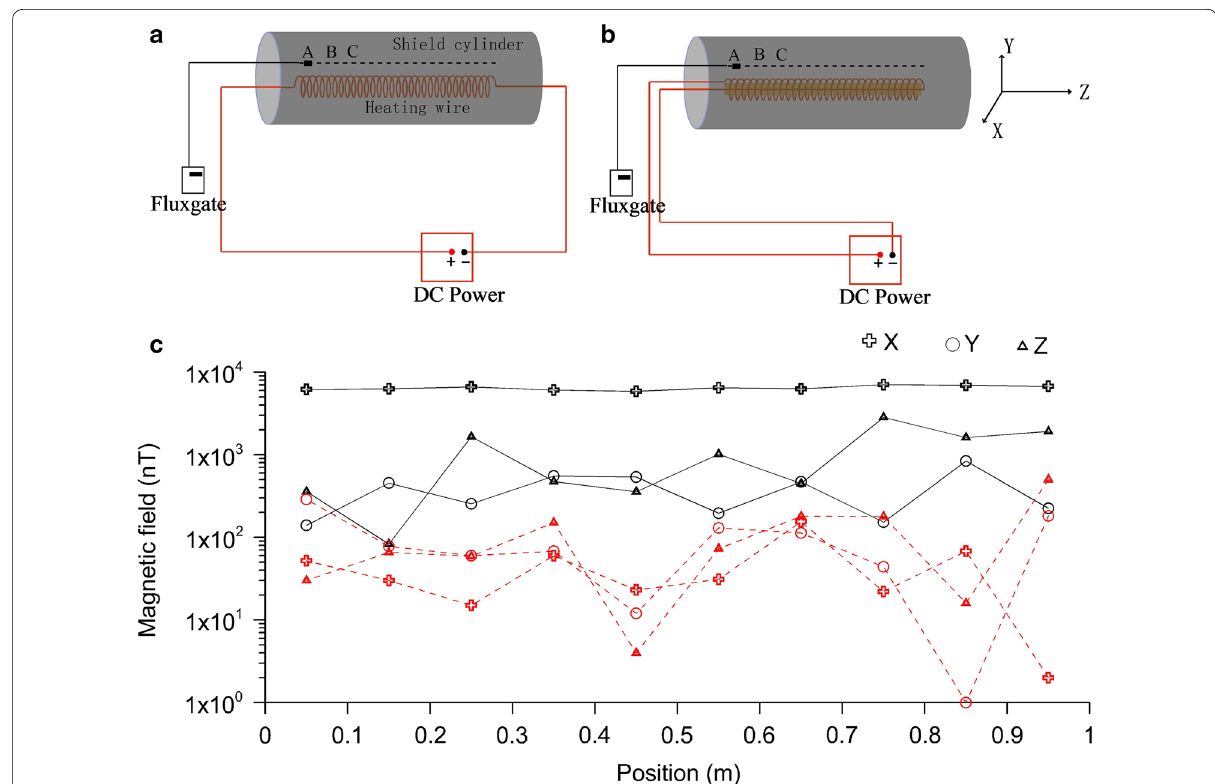
Fig. 6 Magnetic field measurement of conventional solenoid a and new heating wire b . c Current field at different positions, the black line represents the result of conventional solenoid and the red dash line represents the result of a straight core solenoid. The length of solenoid is 1 m, the radius is 4 mm and with pitch distance of 4 mm. The DC current of 1 A applied in the wire during